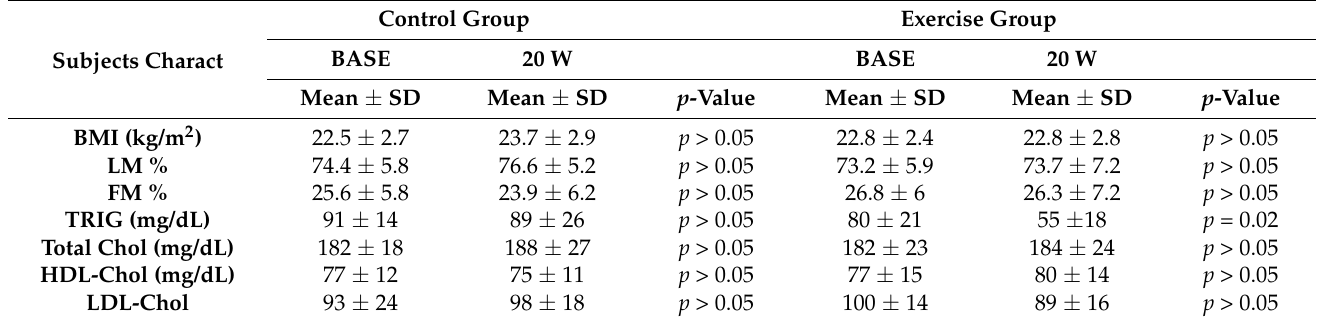
Table 2. Characteristics of the subjects measured baseline and after 20 weeks (20 W) in the two groups of